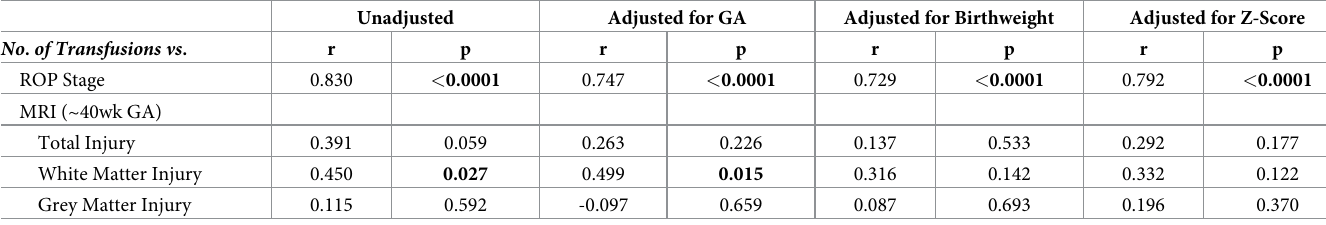
Table 5. Spearman partial correlation of number of transfusions with ROP stage and MRI injury scores.